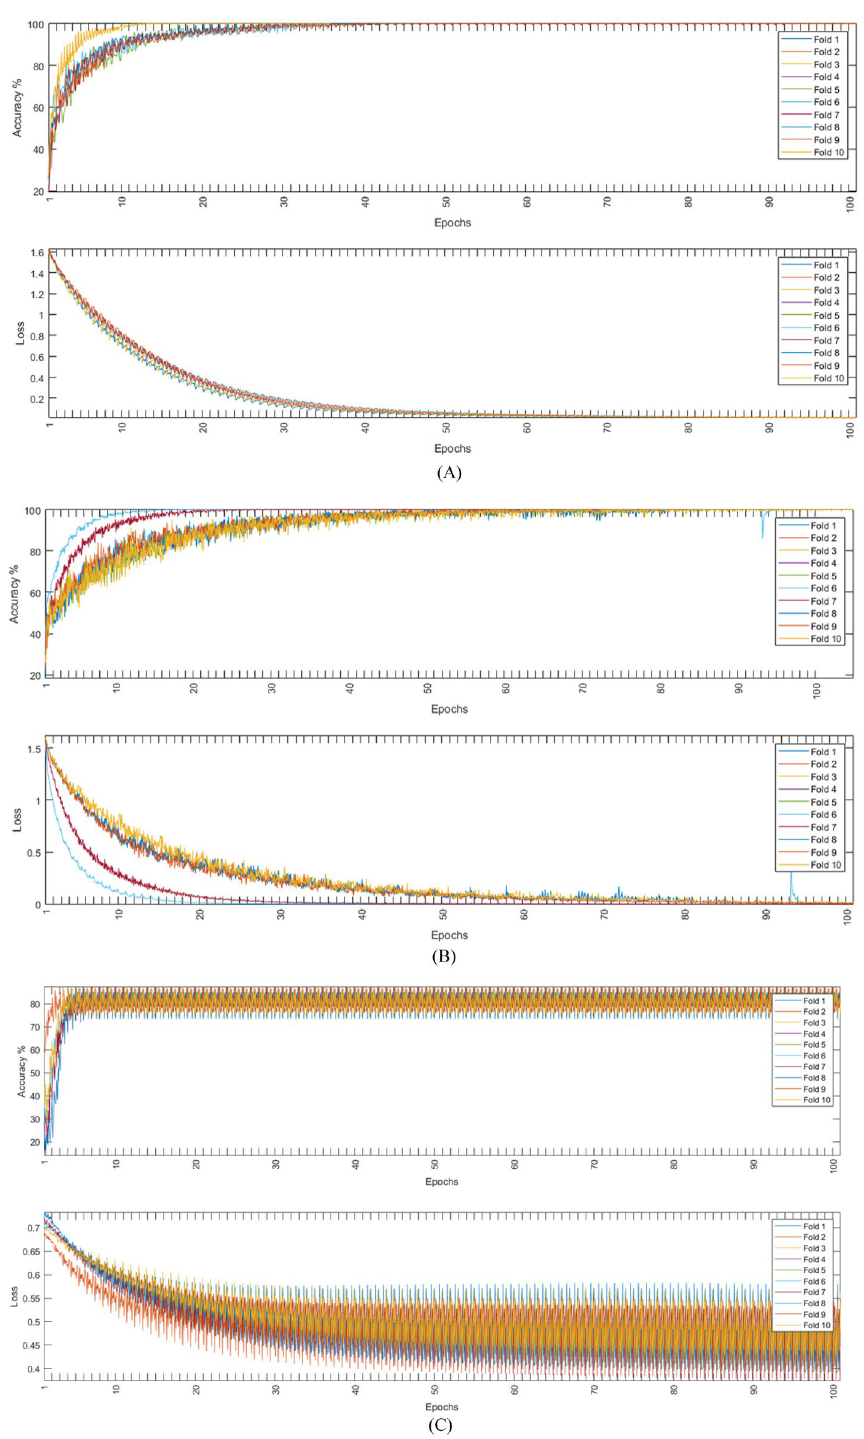
Figure 15. Augmented training accuracy and loss; ( A ) for non-augmented dataset, ( B ) augmented dataset, ( C ) binary